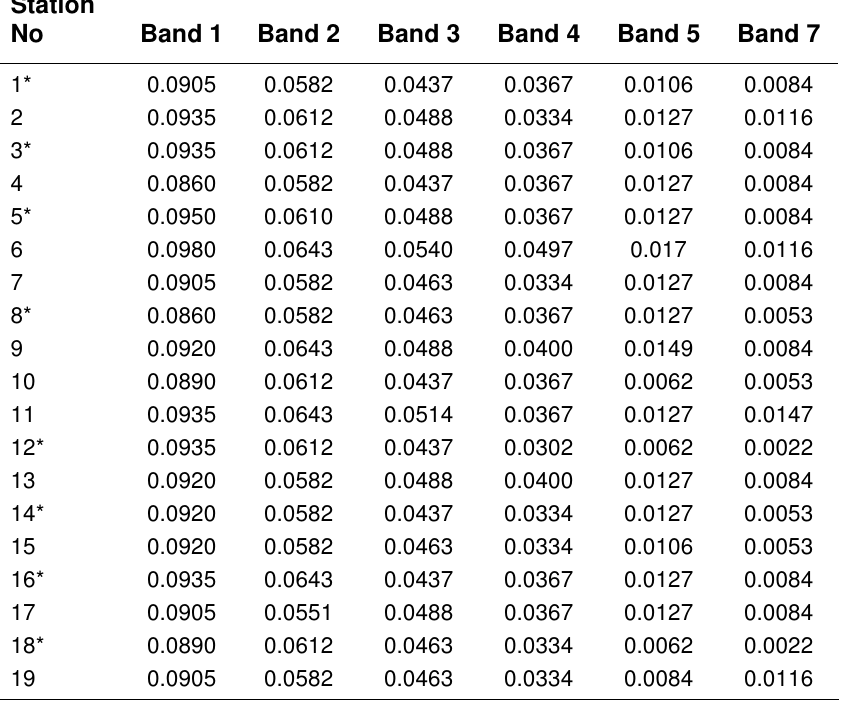
Landsat-5 TM Satellite Image Reflectance Values at WQ Measurement Stations